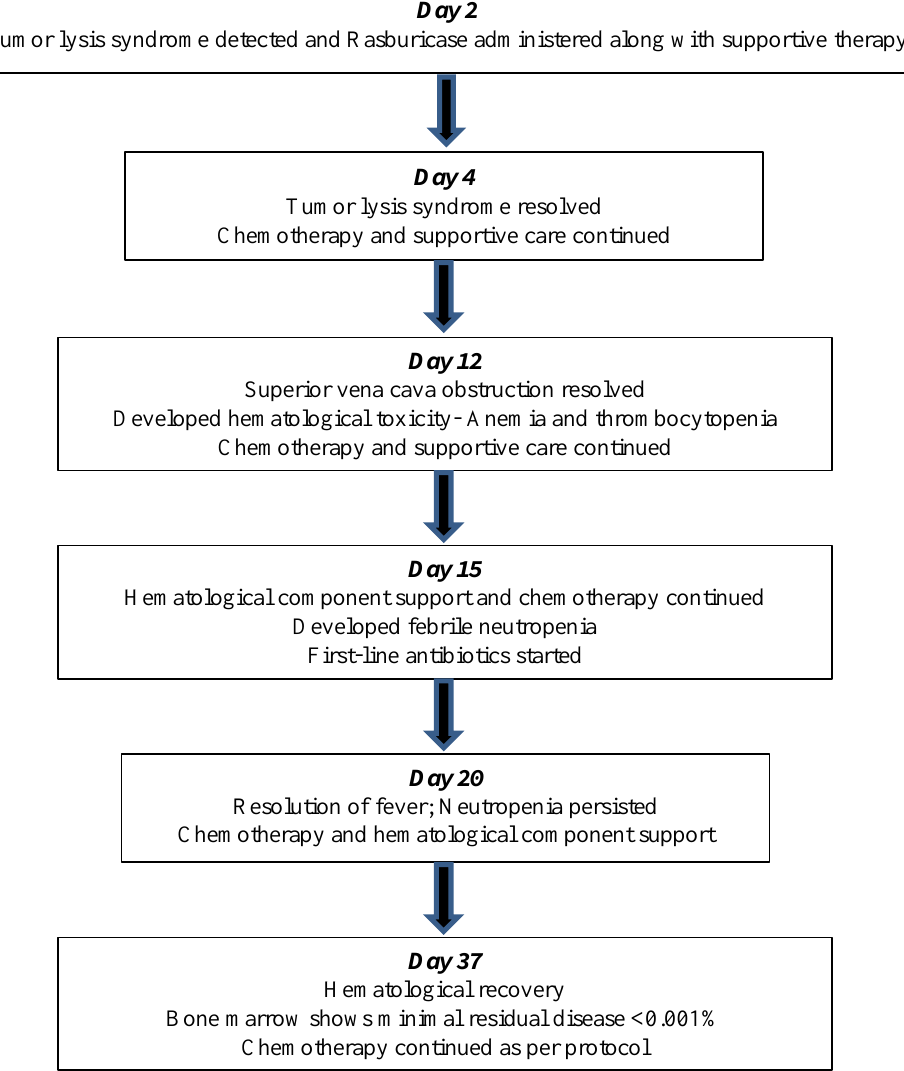
Figure 4. Flowchart depicting the course of events of the patient from the time of presentation till